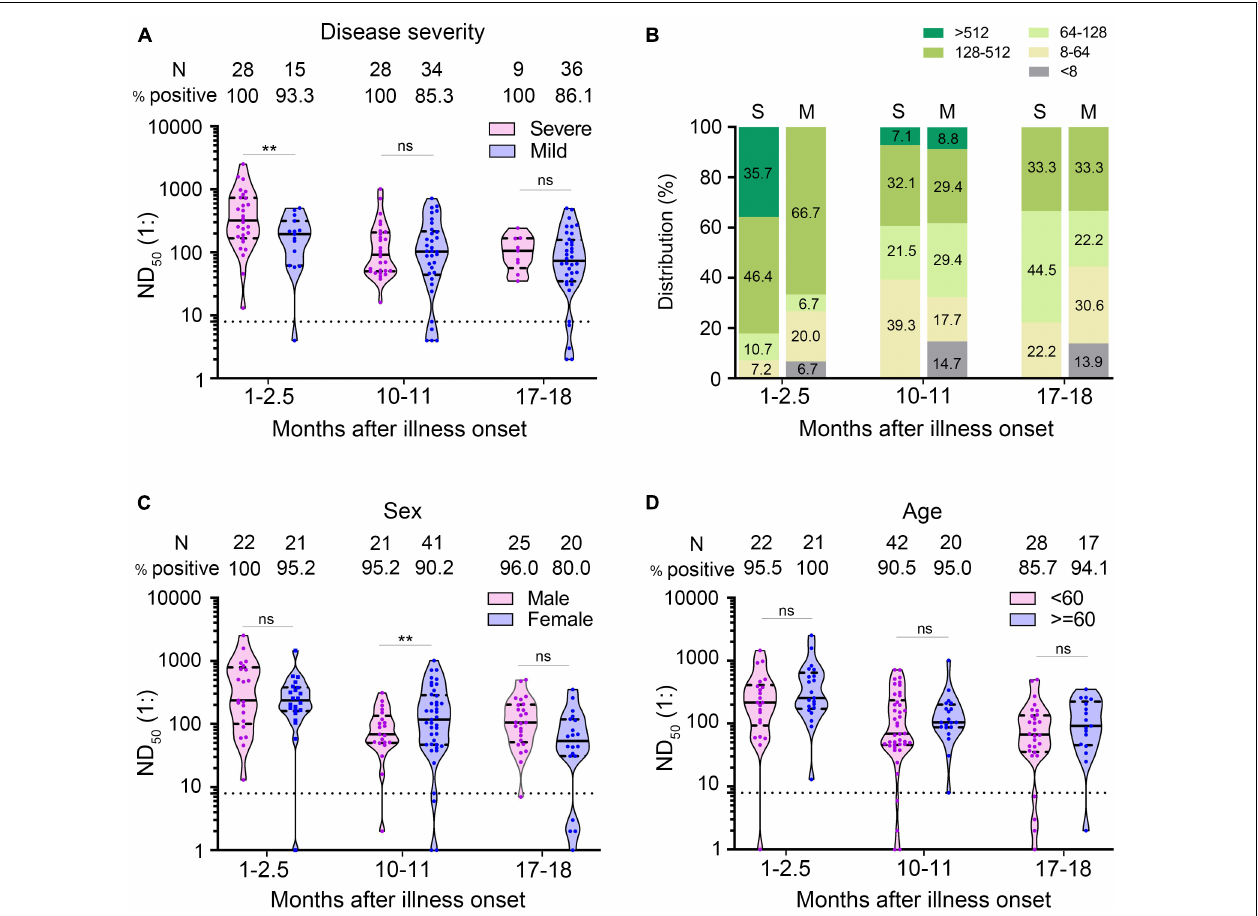
FIGURE 4 | Comparison of neutralizing antibodies in different groups of patients. (A) ND 50 of COVID-19 patients at different times after illness onset according to the severity of the disease. (B) Distribution of ND 50 in sera of COVID-19 patients according to the severity of the disease. (C,D) The ND 50 of COVID-19 patients according to sex (C) and age (D) . Bars represent the median and interquartile range (IQR). The dotted line represents the threshold for positive in this assay. All serum samples were tested at least in duplicate. Multivariate generalized linear models were used to compare the difference between ND 50 and potential factors (i.e., disease severity, sex and age). ** p < 0.01. ns, not significant; S, severe; M, mild; N,